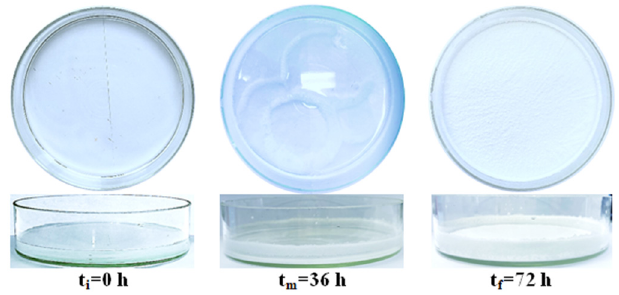
Figure 1. The co-crystallization process for PSAN_0 at different stages.